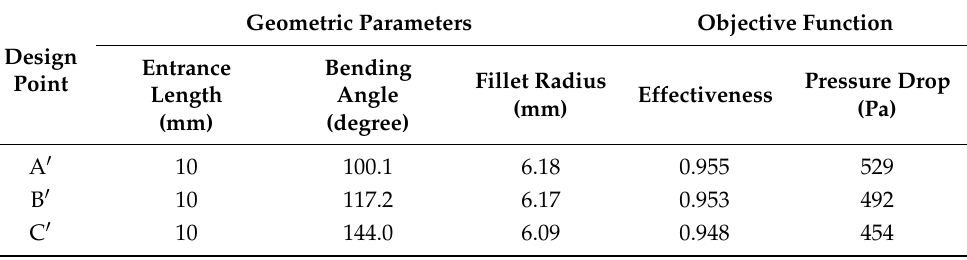
Table 5. Optimal parameters for the design points A (cid:48) , B (cid:48) , and C (cid:48) in the Pareto optimal front.